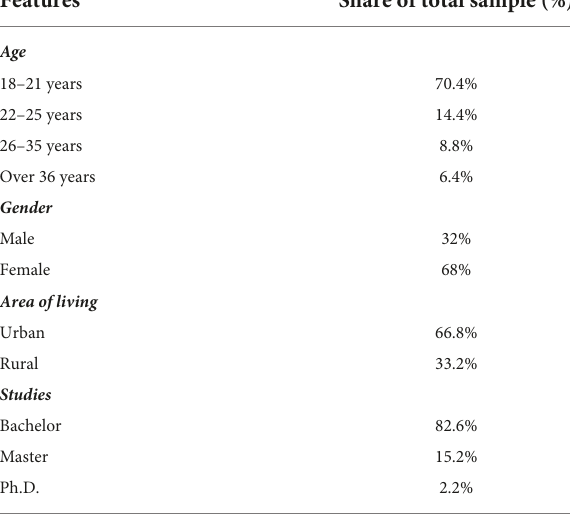
TABLE 1 Sample characteristics.